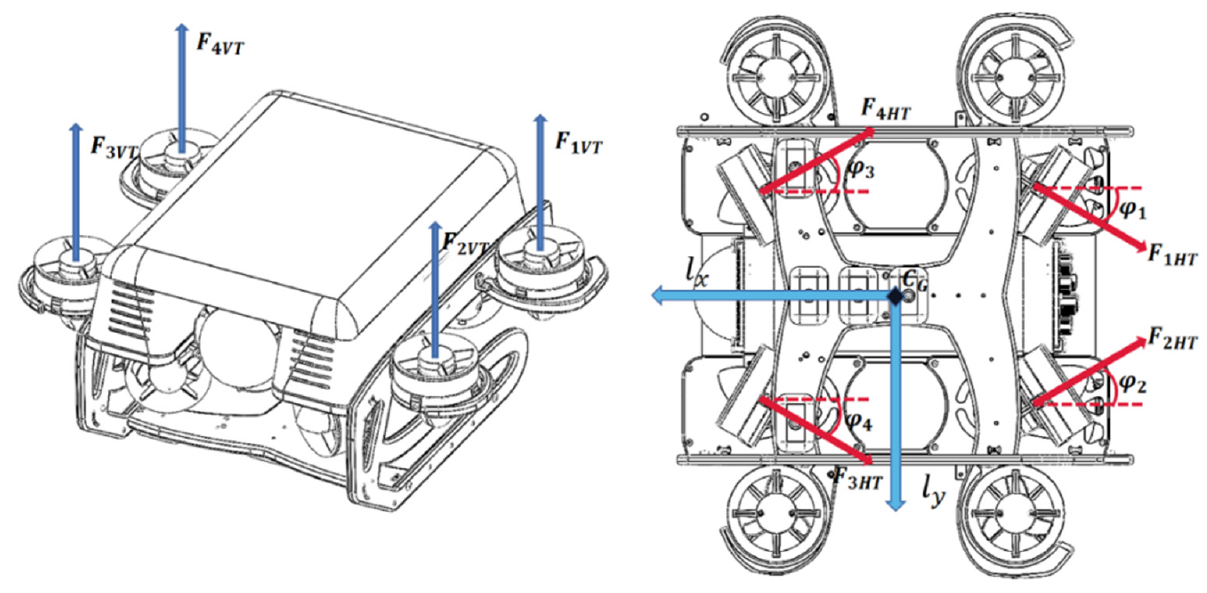
Figure 4. Structure and thruster distribution of an AUV.